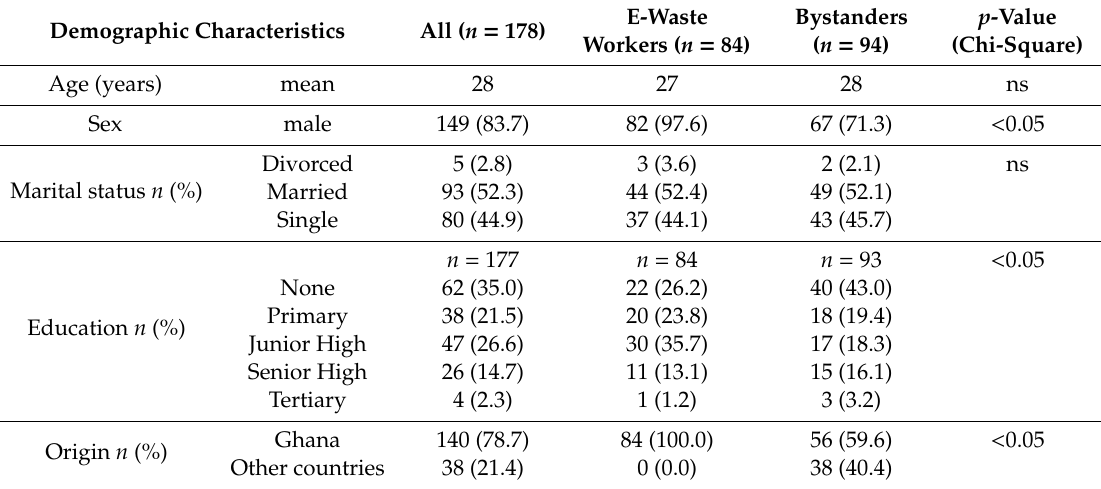
Table 1. Selected demographic characteristics of E-waste workers and bystanders at Agbogbloshie scrap